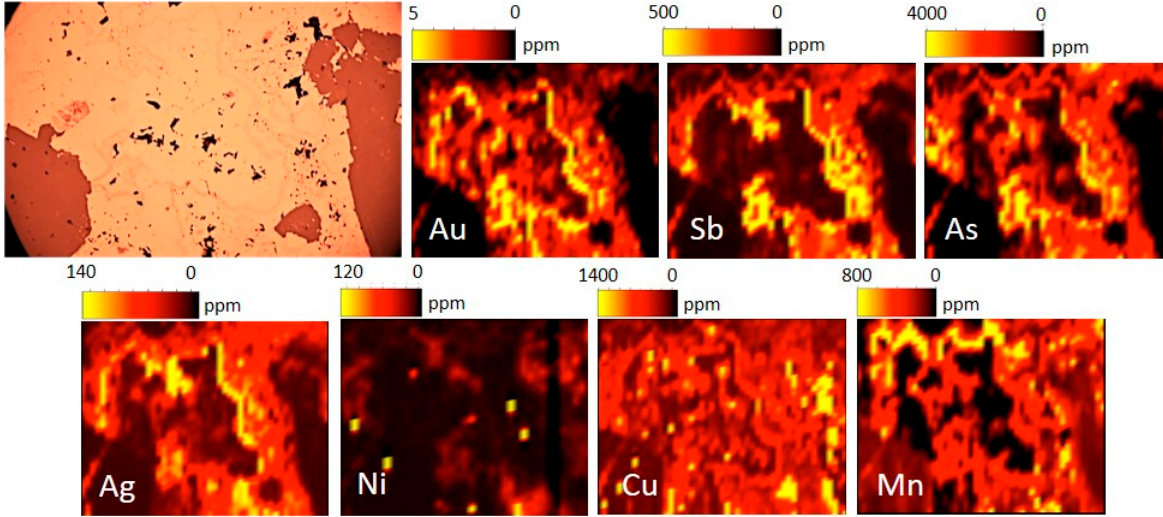
Figure A2. Au, Ag, As, Sb, Ni, Cu and Mn distribution maps of the colloform banded pyrite (Py III) aggregate 3 from sample Cast-004. The maps show semi-quantitative values.